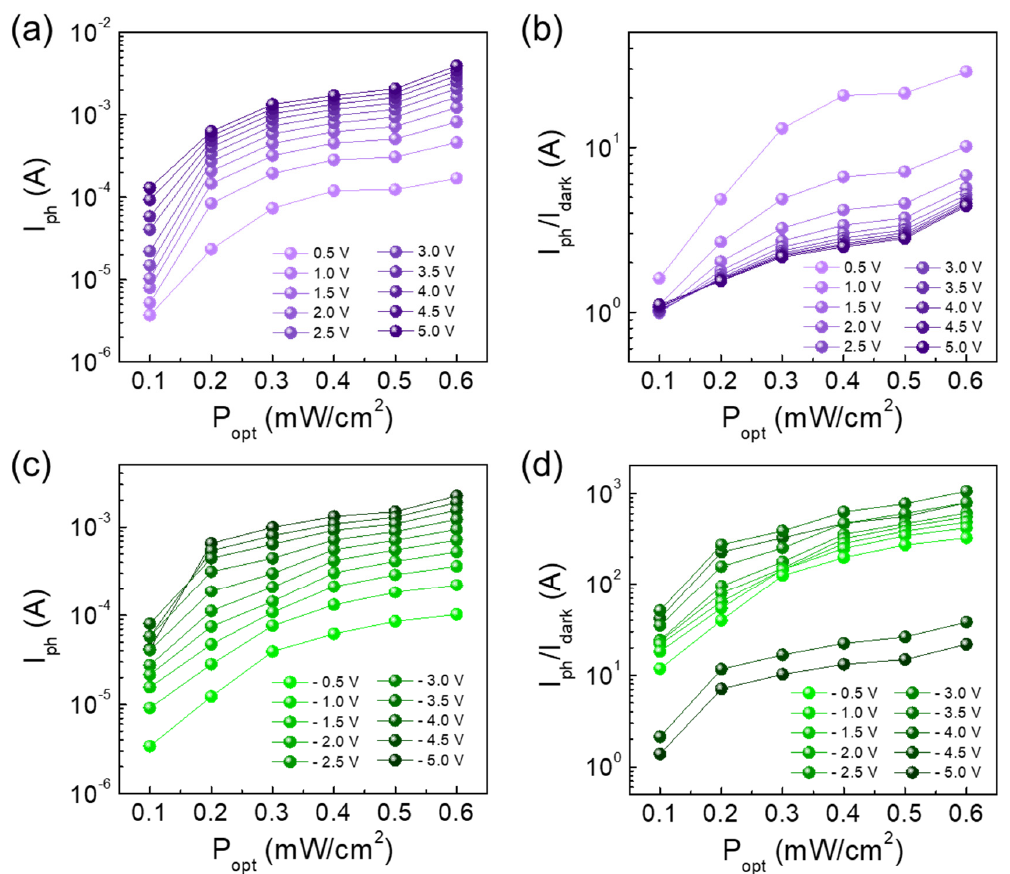
Figure 6. Photoresponse characteristics at various bias voltages of the Y3 device: ( a ) I ph and ( b ) I ph /I dark as a function of P opt at forward bias states; and ( c ) I ph and ( d ) I ph /I dark at reverse bias states.